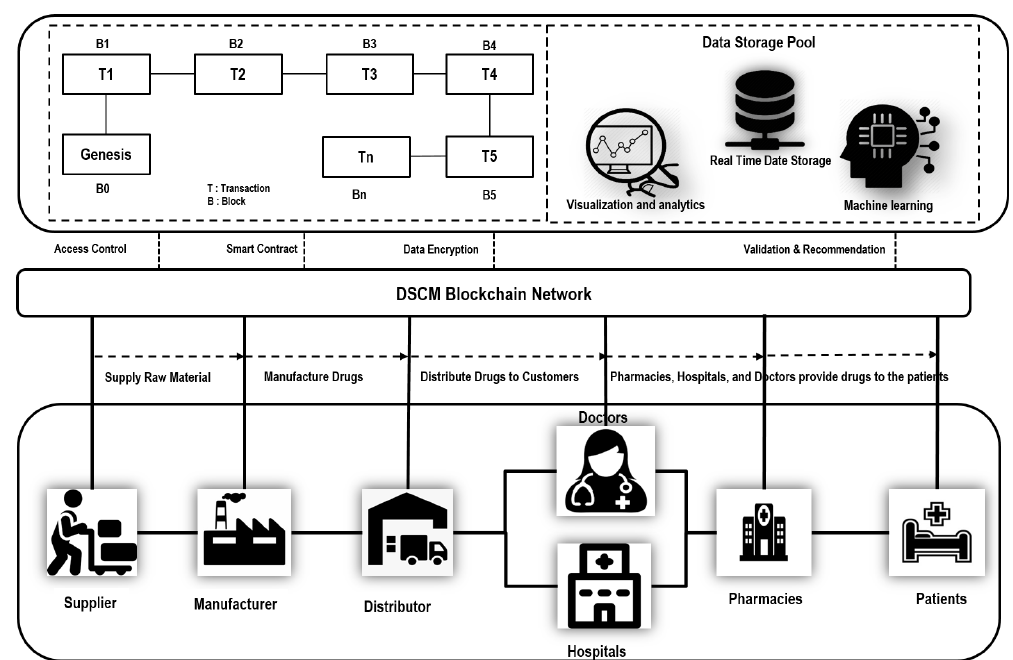
Figure 1. Overview of drug supply chain management (DSCM) system with blockchain.